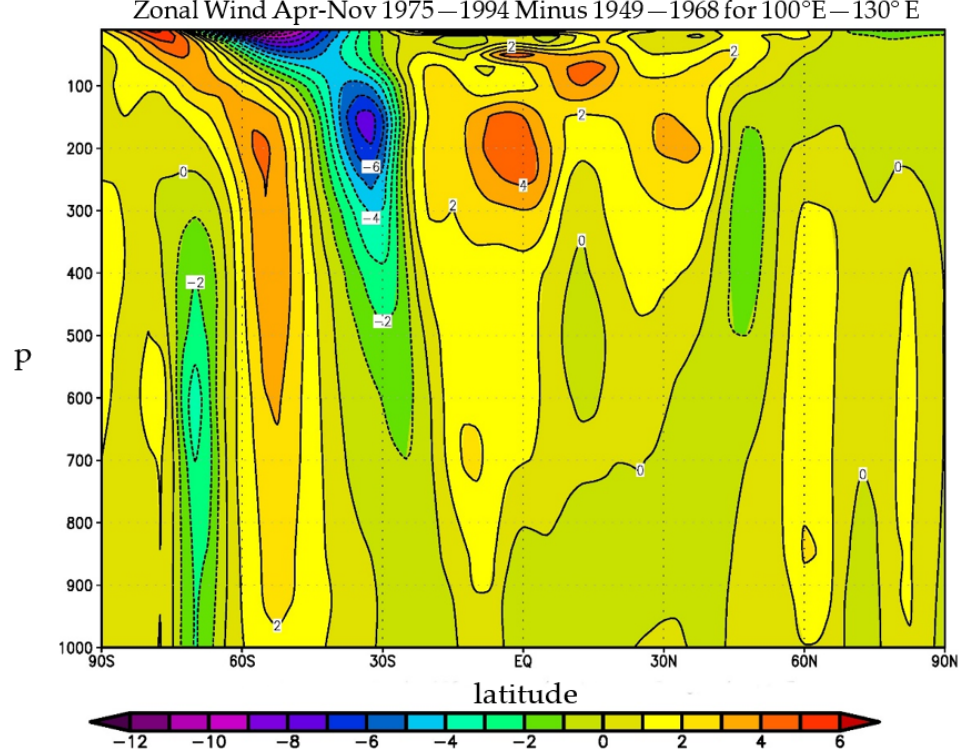
Figure 4. Vertical cross-section of April–November zonal wind (m s − 1 ) averaged between 100 ◦ E–130 ◦ E as a function of latitude and pressure (p in hPa) for (1975–1994) minus (1949–1968). Contour intervals are 1 ms − 1 and confidence levels C L > 95% where the magnitude of the plotted differences ≥ 2 ms − 1